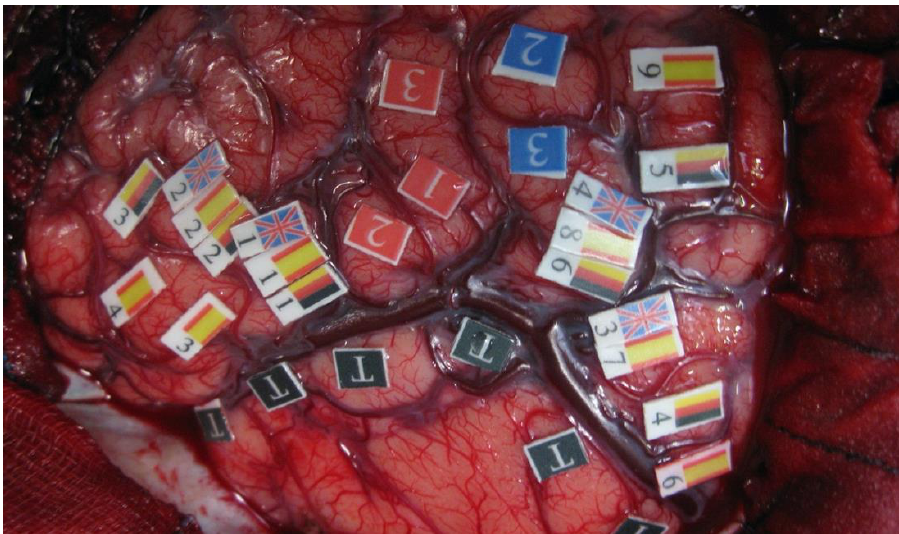
Figure 1. An intraoperative view of the window exposed by a left frontoparietotemporal craniotomy. Red numbers (1 – 2 – 3) represent the motor stem on the precentral gyrus. Blue numbers (2 – 3) represent the sensory stem on the postcentral gyrus. The areas marked with flags represent those regions in which language disturbances were elicited during the direct cortical stimulation, either specific to one language or shared among several of them. We can see at the ventral premotor cortex that it is being shared by English, German, and Spanish.